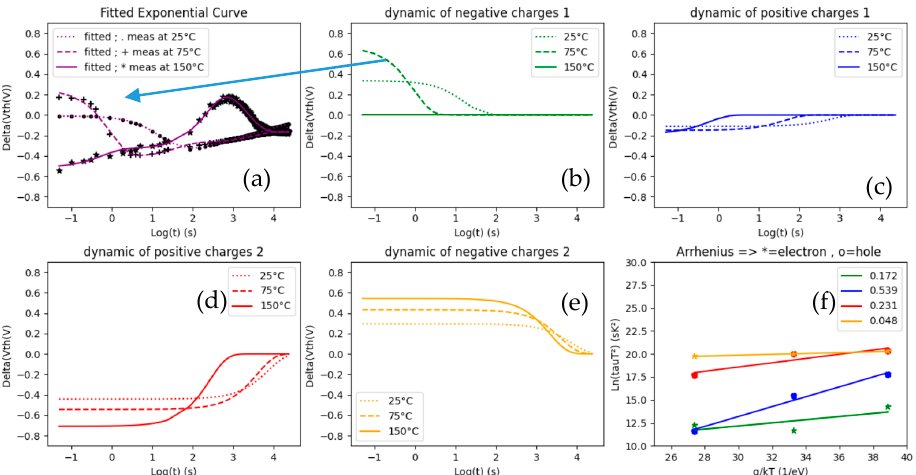
Figure 8. Design B wafer 1; ( a ) measurement at 25, 75 and 150 °C; ( b ) extraction of dynamic first level of negative charges; ( c ) extraction of dynamic first level of positive charges; ( d ) extraction of dynamic second level of negative charges; ( e ) extraction of dynamic second level of positive charges; ( f ) report of the four levels of charge in an Arrhenius graph (extraction of energy levels). Subfigures ( a – e ), show the Vth shift due to one trap level in function of time measured at 25, 75 and 150 °C. Subfigure ( f ) is the extraction of traps energies levels for each trap level.